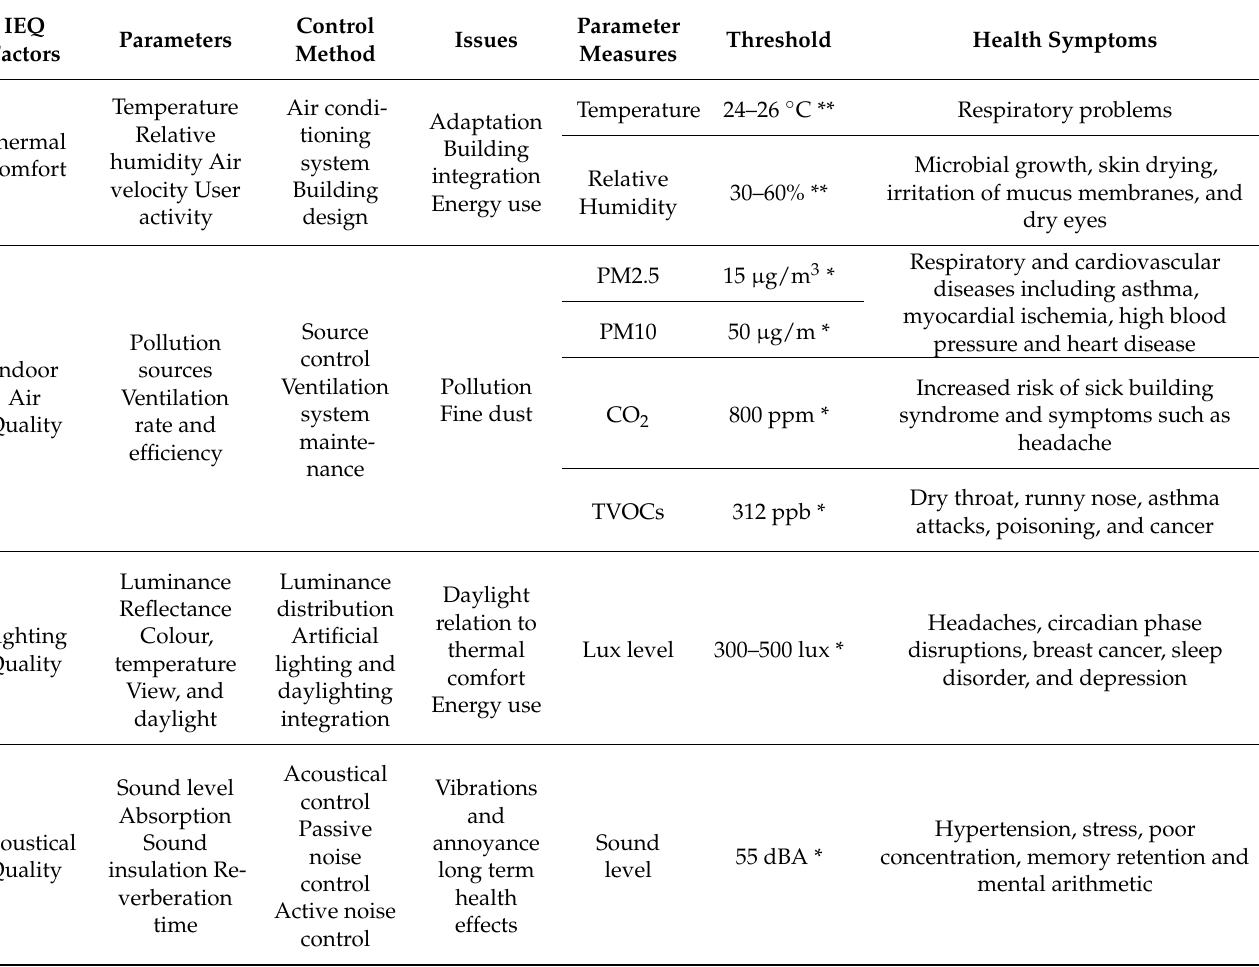
Table 2. IEQ factors, parameters, control methods, issues, threshold, and